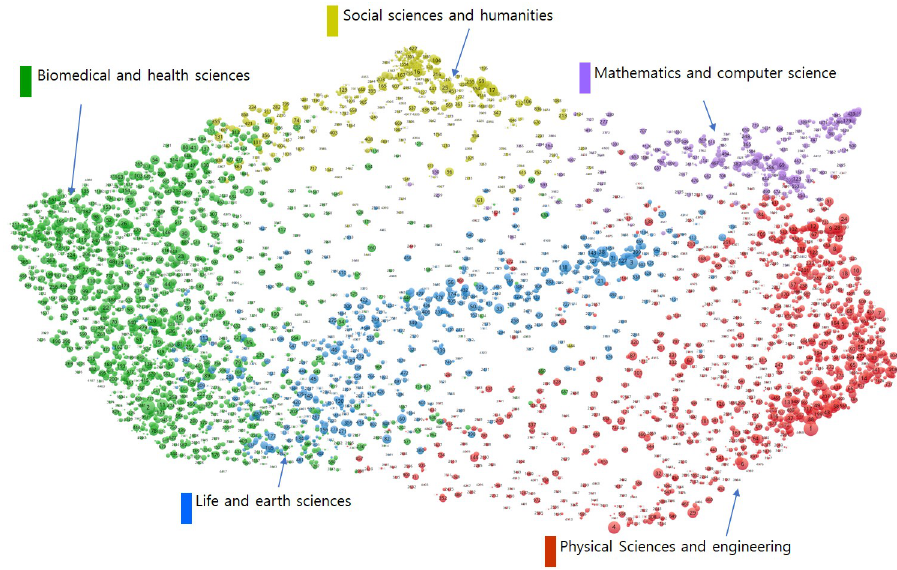
Fig 6. Similarity-based mapping of all technology clusters.